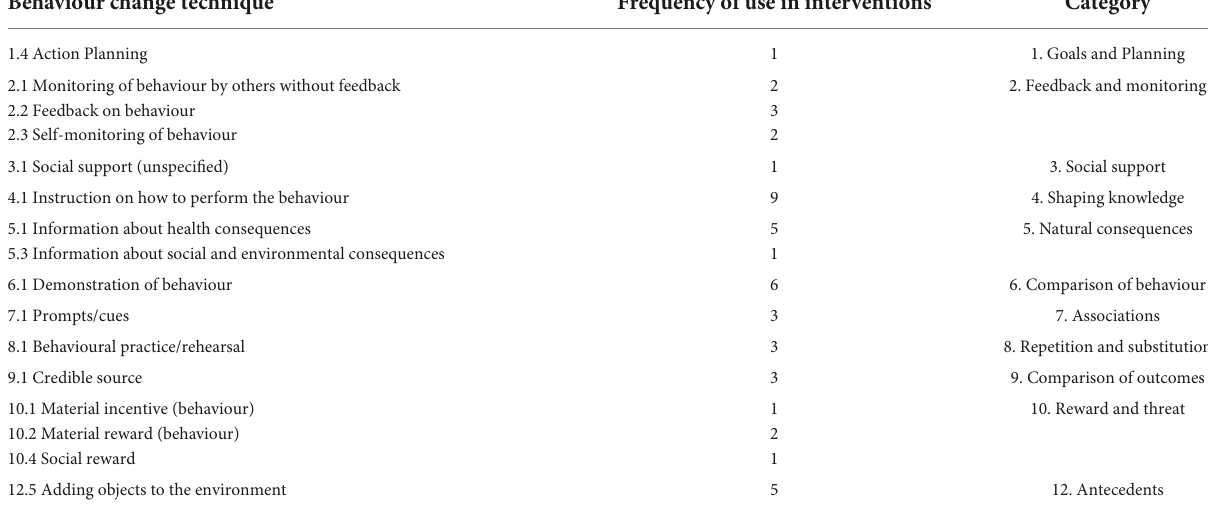
TABLE 1 Type and frequency of behaviour change techniques used in oral health interventions for people with SMI. Behaviour change